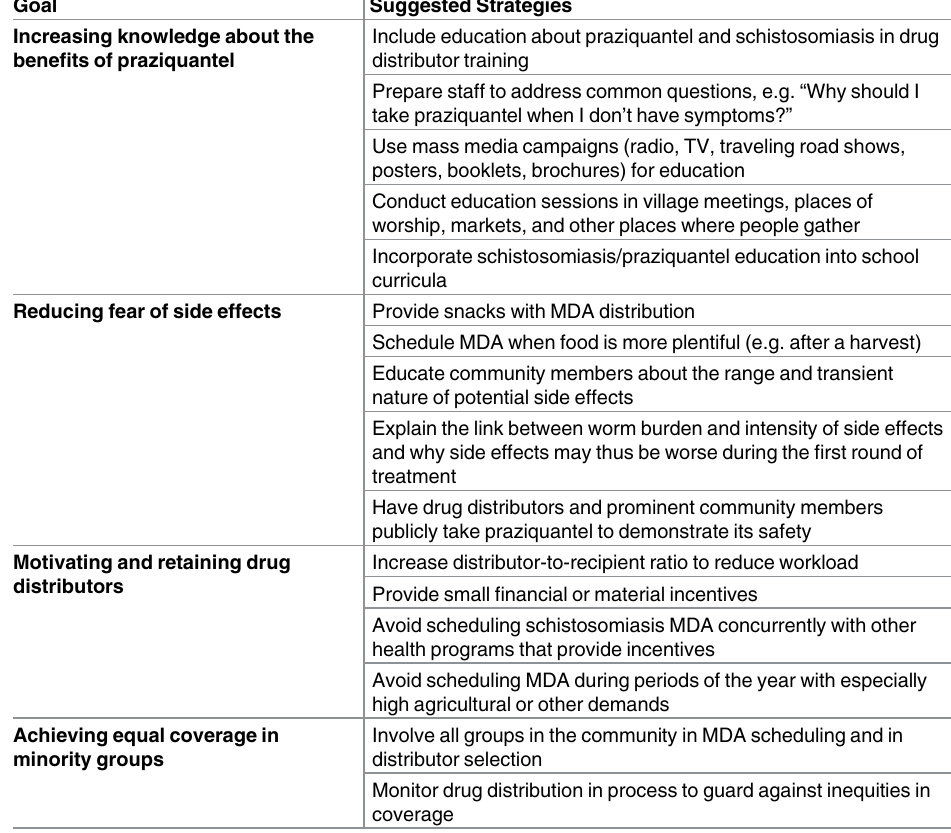
Table 3. Specific recommendations for improving MDA coverageprovided in the reviewed